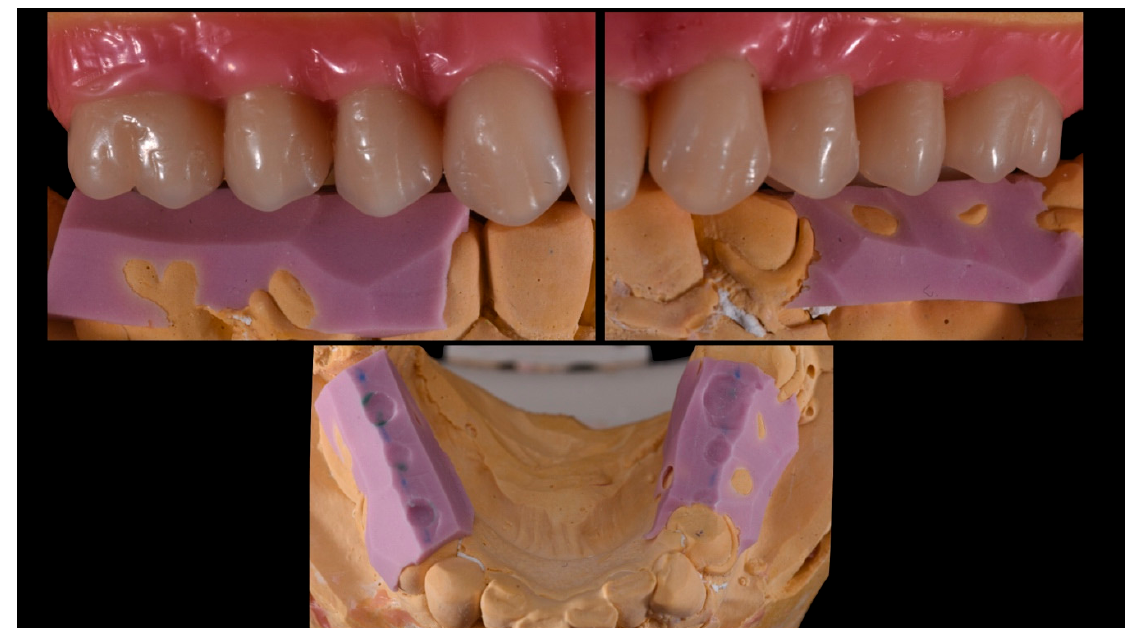
Figure 7. Setup of the teeth and the silicon gigs for transfer of information.